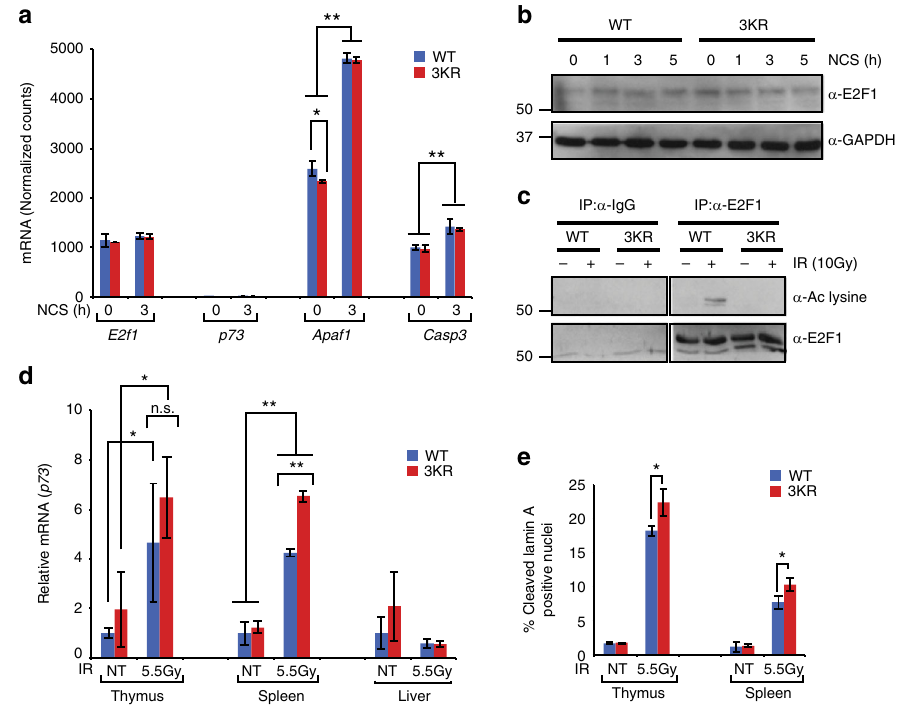
Fig. 4 Characterization of the E2F1 acetylation 3KR knock-in mouse model. a RNA-seq was performed on wild-type (WT) and E2f1 3KR/3KR (3KR) MEFs untreated or treated with NCS (250 ng/ml for 3 h) and the normalized mRNA counts for E2f1 , p73 , Apaf1 , and Caspase3 ( Casp3 ) are presented. b Western blot analysis was performed to examine E2F1 protein levels in primary wild-type (WT) and E2f1 3KR/3KR (3KR) MEFs before and after DNA damage with NCS (250 ng/ml) for the indicated times. c Wild-type and E2f1 3KR/3KR MEFs were untreated or exposed to 10 Gy IR and cell extracts made 2 h later. Co- immunoprecipitation was performed using control IgG or antibody to E2F1 (C-20, rabbit polyclonal) followed by western blot analysis for acetylated lysine (top) or E2F1 (bottom) using a different antibody (KH95, mouse monoclonal). d Wild-type (WT) and E2f1 3KR/3KR (3KR) mice were exposed to 5.5 Gy of IR and tissues collected 2 h later. Total RNA was isolated and cDNA was prepared by RT-PCR using random hexamer primer. Expression of p73 in the thymus, spleen, and liver was determined by qPCR. e Wild-type (WT) and E2f1 3KR/3KR (3KR) mice were exposed to 5.5 Gy of IR and thymus and spleen tissues were collected 2 h later. Tissue sections were stained for the cleaved form of Lamin A. The average of percentage of positive nuclei is presented. All graphs represent average ± SD of three independent experiments ( n = 3) of cells or mice. P values were calculated by unpaired Student ’ s t test. ** P ≤ 0.01 is highly signi fi cant and * P ≤ 0.05 is signi fi cant. Source data of b and c are provided as Supplementary Data 5. Raw data of a , d , and e are in Source Data